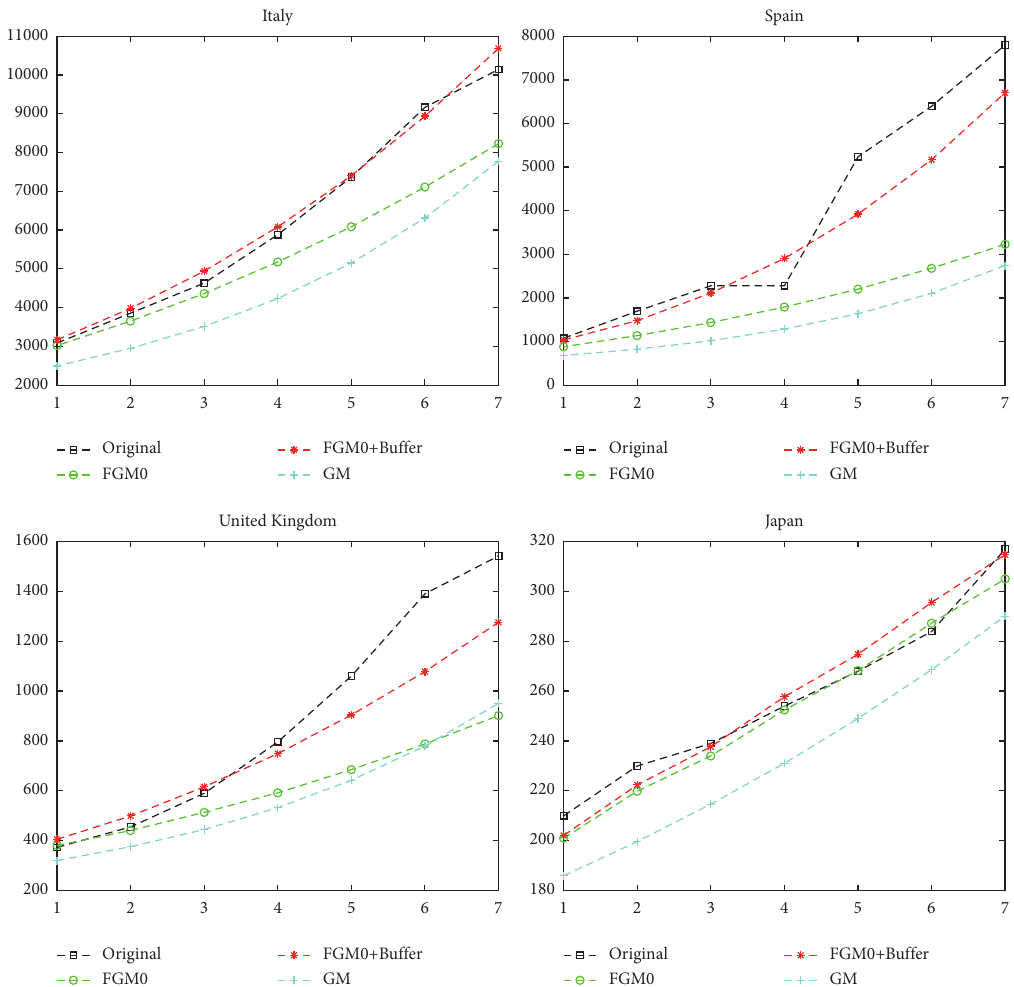
Figure 2: The prediction performance in the early stage (part